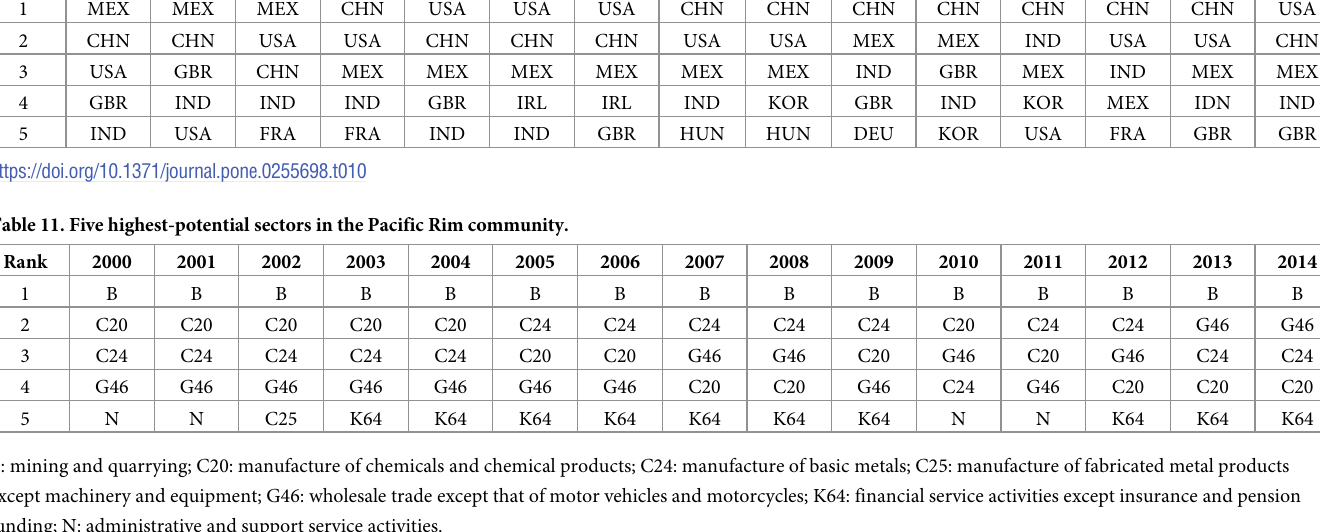
Table 10. Five lowest-potential countries in the Pacific Rim community. Rank